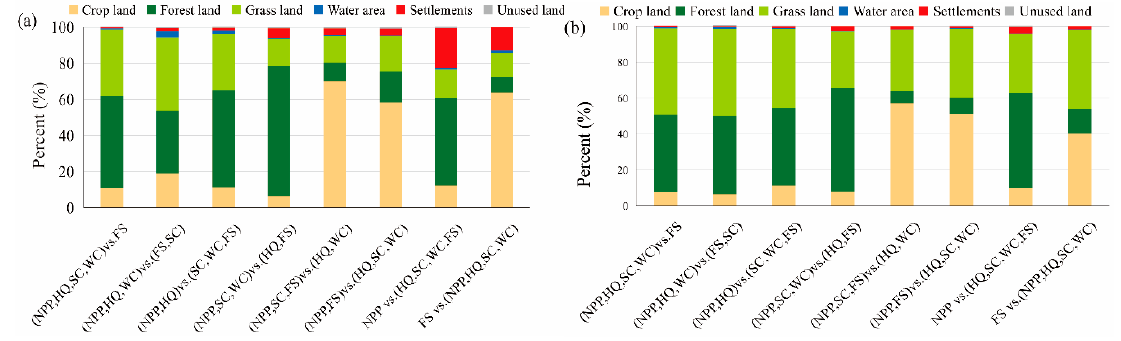
Figure 7. Trade-offs and synergies among multiple ecosystem services in different land use